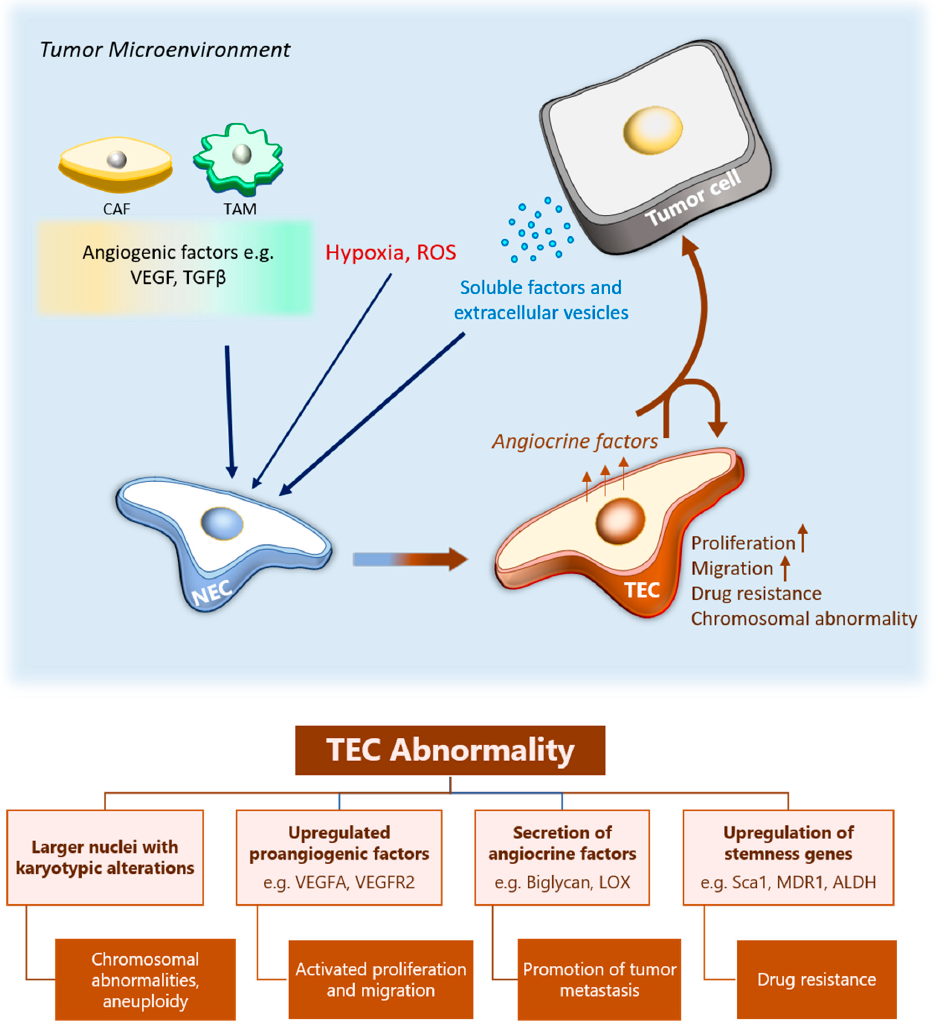
Figure 1. TEC abnormality. Soluble factors and extracellular vesicles released from tumor cells, CAFs and TAMs, induce endothelial cells in pre-existing blood vessels to initiate angiogenesis to form tumor blood vessels. In the process, the NECs are transformed into TECs in the formed tumor